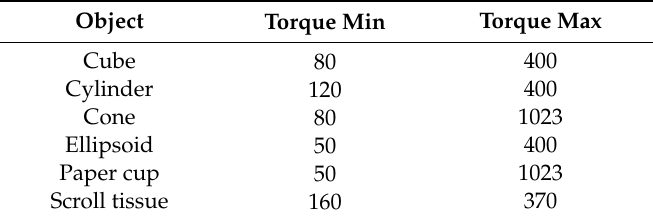
Table 5. Min and max values of grasping torque.